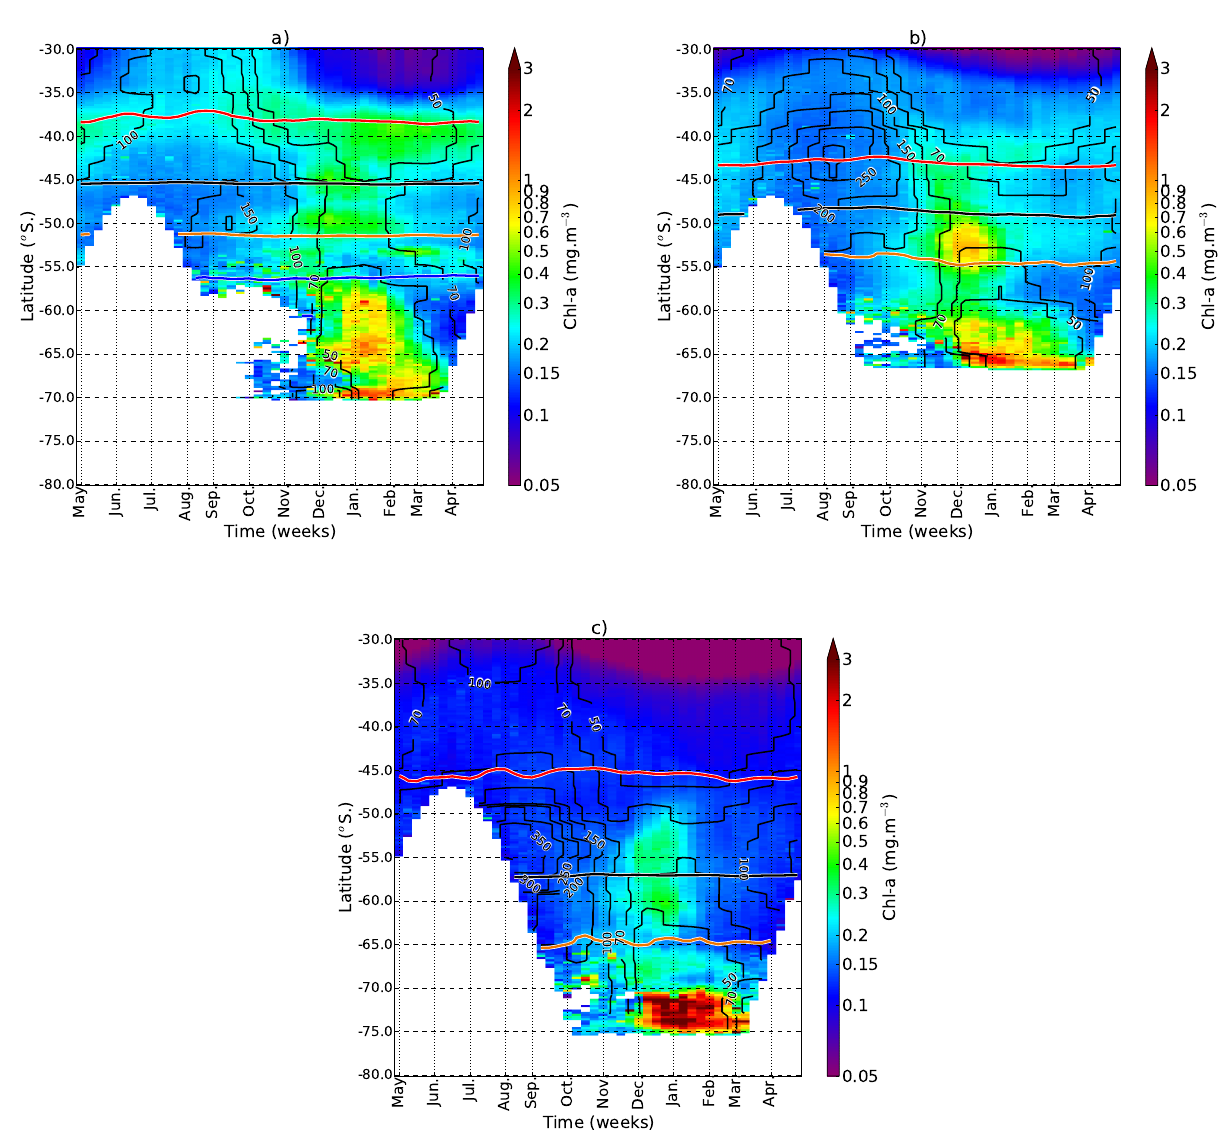
Fig. 8. Mean seasonal cycles (May to April – x-axis) of chlorophyll (colour scale) and annual mean MLD in metres (contours) as a function of latitude (30–80 ◦ S – y-axis) for a 10 ◦ longitudinal transect in (a) the Atlantic (0–10 ◦ E), (b) the Indian (85–95 ◦ E) and (c) the Pacific (110–100 ◦ W) Oceans. Mean (1998–2007) frontal positions are shown for the STF (red), the SAF (black), the PF (orange) and the SACCF